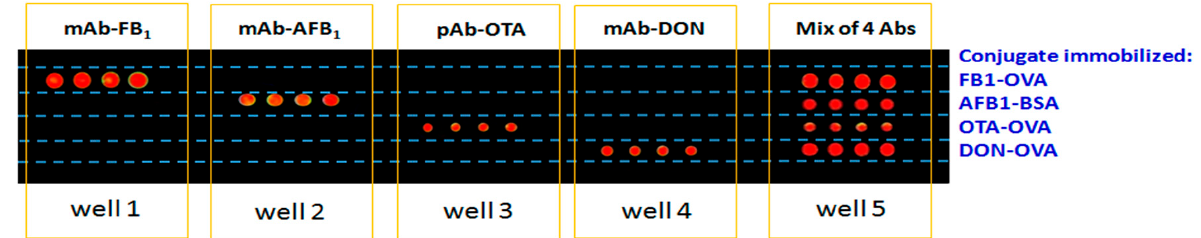
Figure 6. Representative fluorescence image obtained from a microarray created on an Ag-3D slide by spotting each one of the mycotoxin-conjugates along the long axis of the substrate (row 1: FB1-OVA; row 2: AFB1-BSA; row 3: OTA-OVA; row 4: DON-OVA) and probing four spots of each conjugate with either each one of the mycotoxin antibodies separately (wells 1 to 4) or a mixture of all antibodies (well 5).